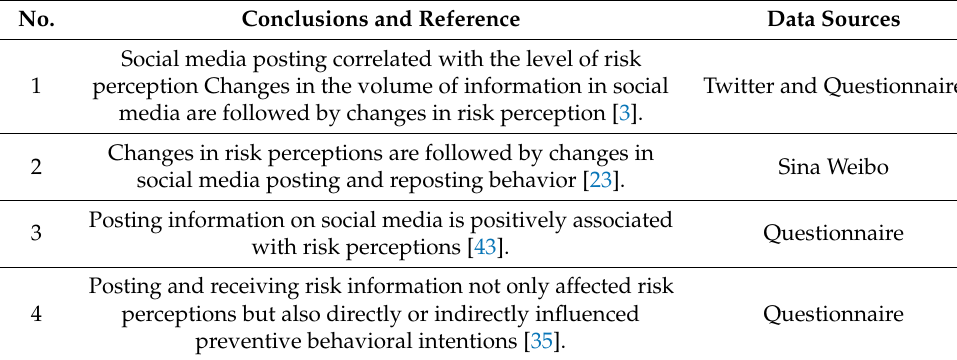
Table 1. The relationship between social media posting and risk